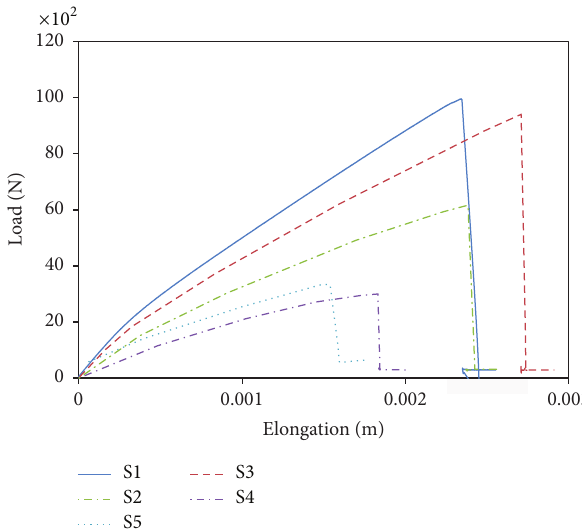
Figure 11: Tensile-load elongation curves for kenaf